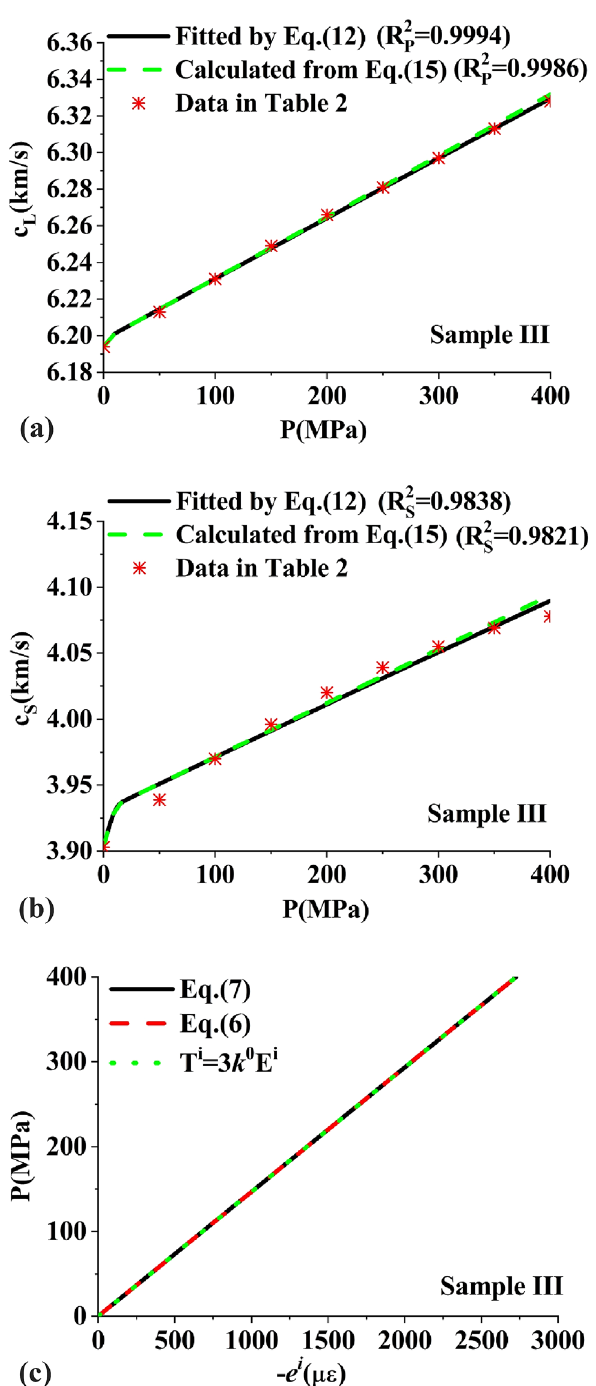
Fig. 3 Fitted results by Eq. (12), the calculated results by Eq. (15) and corresponding constitutive law for sample III, where P = − T i and e i = − 1 + √ 1 + 2 E i . a P-wave, b S-wave, and c constitutive